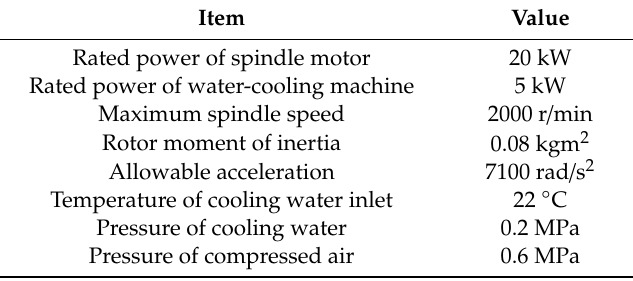
Figure 4. Main parameters of machined gear and hob tool. Table 1. Relevant parameters of the motorized spindle system.